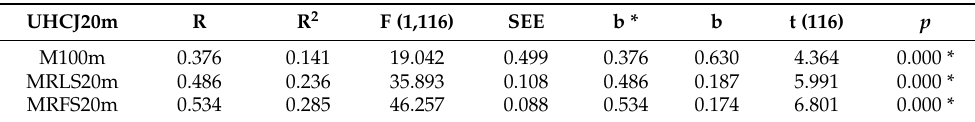
Table 2. The results of a simple regression analysis between the predictor variable UHCJ20m and the criterion variables M100m, MRLS20m, and MRFS20m. UHCJ20m